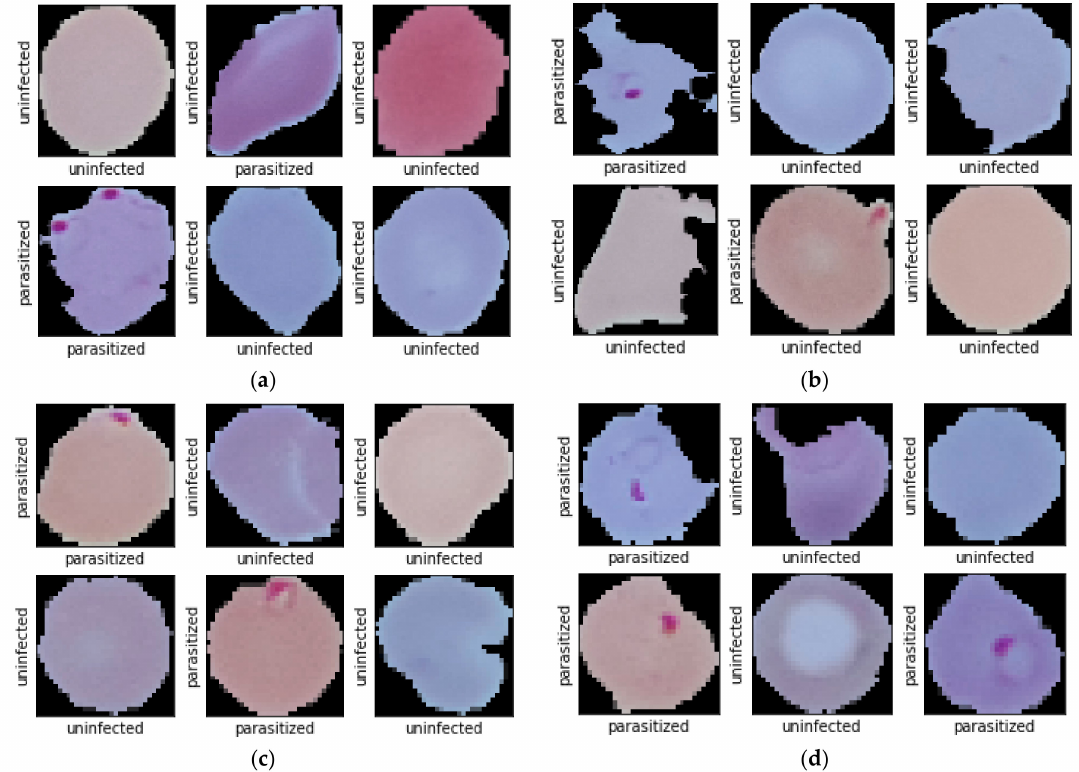
Figure 6. Predicted results where X-axis represents ground-truth value and Y-axis represents predictions of the model: ( a ) depicts predicted result of image 64 × 64 with Augmentation ( b ) depicts predicted result of image 64 × 64 without Augmentation ( c ) depicts predicted result of image 32 × 32 with Augmentation and ( d ) depicts predicted result of image 32 × 32 without Augmentation.